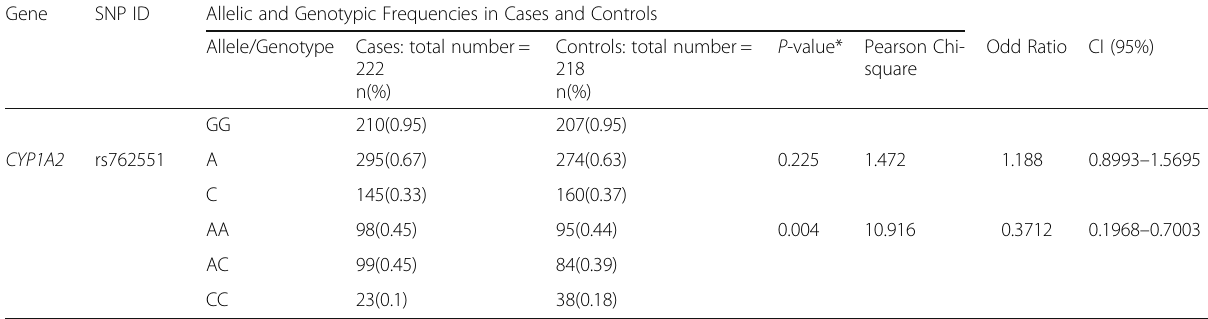
Table 3 Association of the investigated CYP450 candidate gene polymorphisms and breast cancer (BC) (Continued) Gene SNP ID